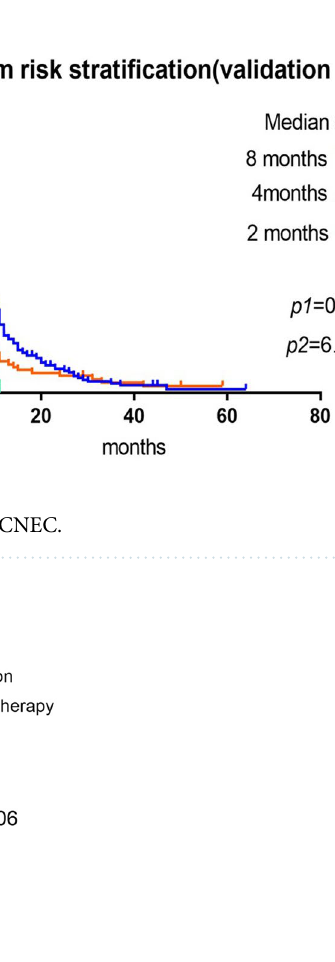
Figure 4. Prognosis of different treatment methods for advanced unoperated